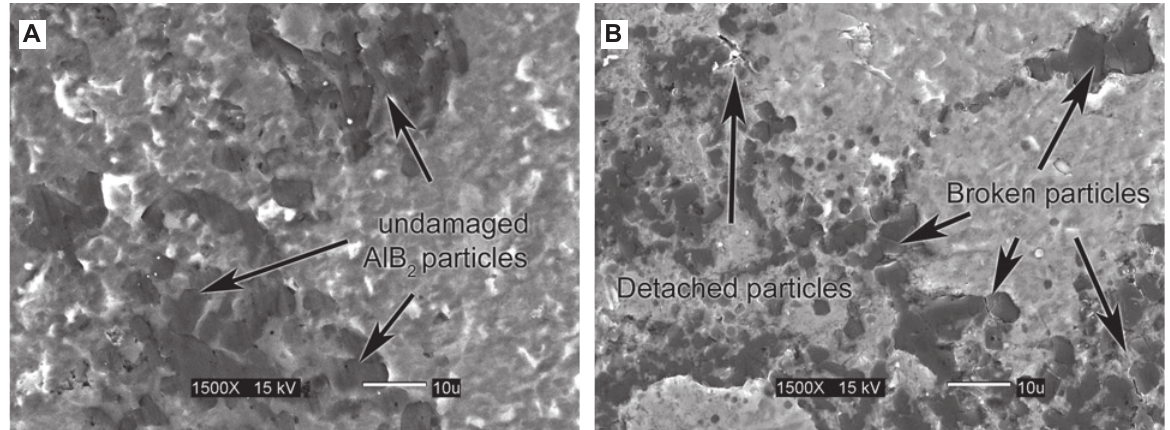
Figure 5 SEM images of Rockwell indentation on both composites studied within the Rockwell indentation mark on a composite containing (A) diboride particles and (B) dodecaboride